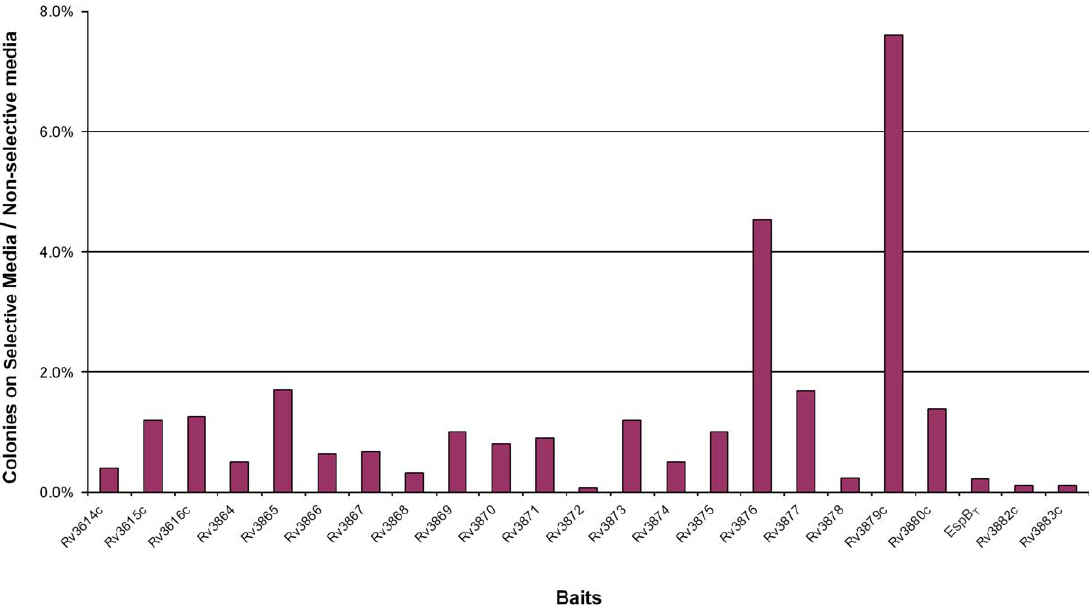
Figure 4. Bacterial Two-Hybrid Analysis of Interaction of EspB T with Proteins of extRD1 The target plasmid containing EspB T fused to the RNA polymerase alpha subunit was co-transformed with each of the bait plasmids containing the indicated extRD1 proteins fused to the lambda repressor into the reporter validation strain. Shown is the ratio of growth of the co-transformants on selective ( þ 5 mM 3AT) versus non-selective plates. The experiment depicted is representative of three independent determinations.